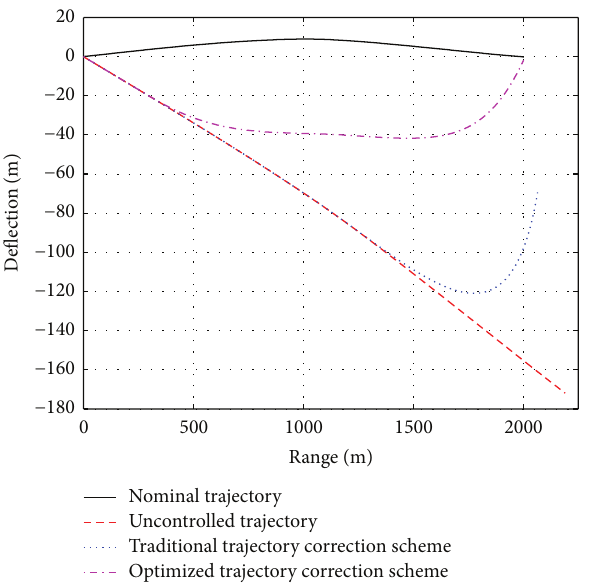
Figure 21: Deflection versus